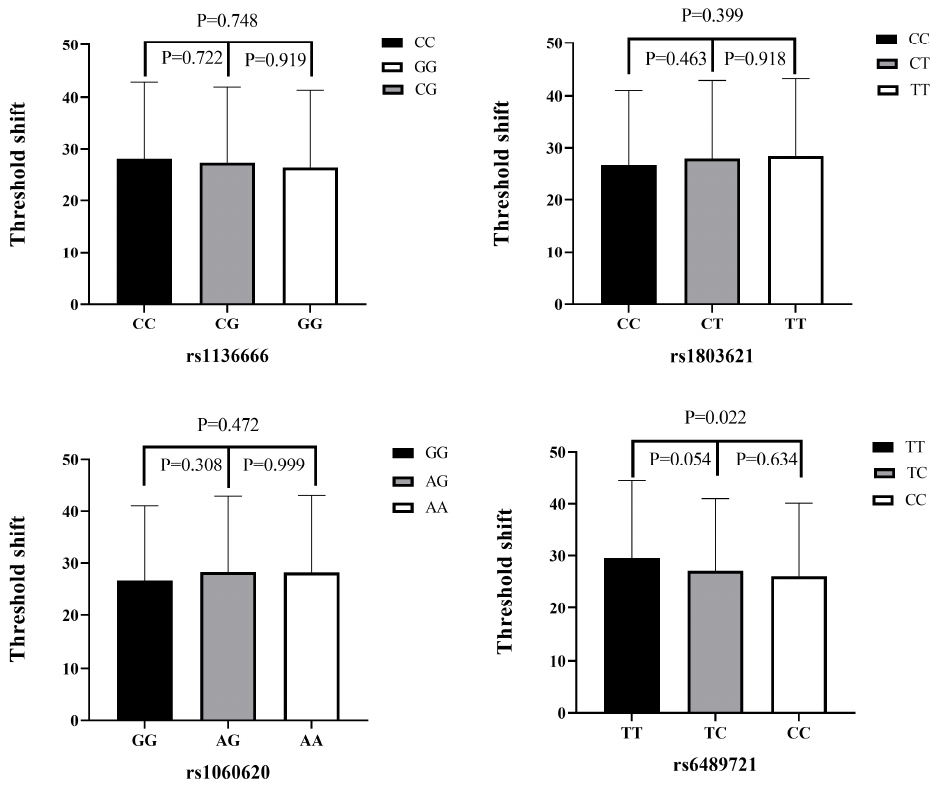
Figure 2. High-frequency hearing threshold shifts according to SNP genotype. A comparison of high-frequency hearing threshold shifts among rs1136666, rs1803621, rs1060620, and rs6489721 genotypes in all subjects. Data presented as mean ± standard deviation and analyzed by ANOVA.